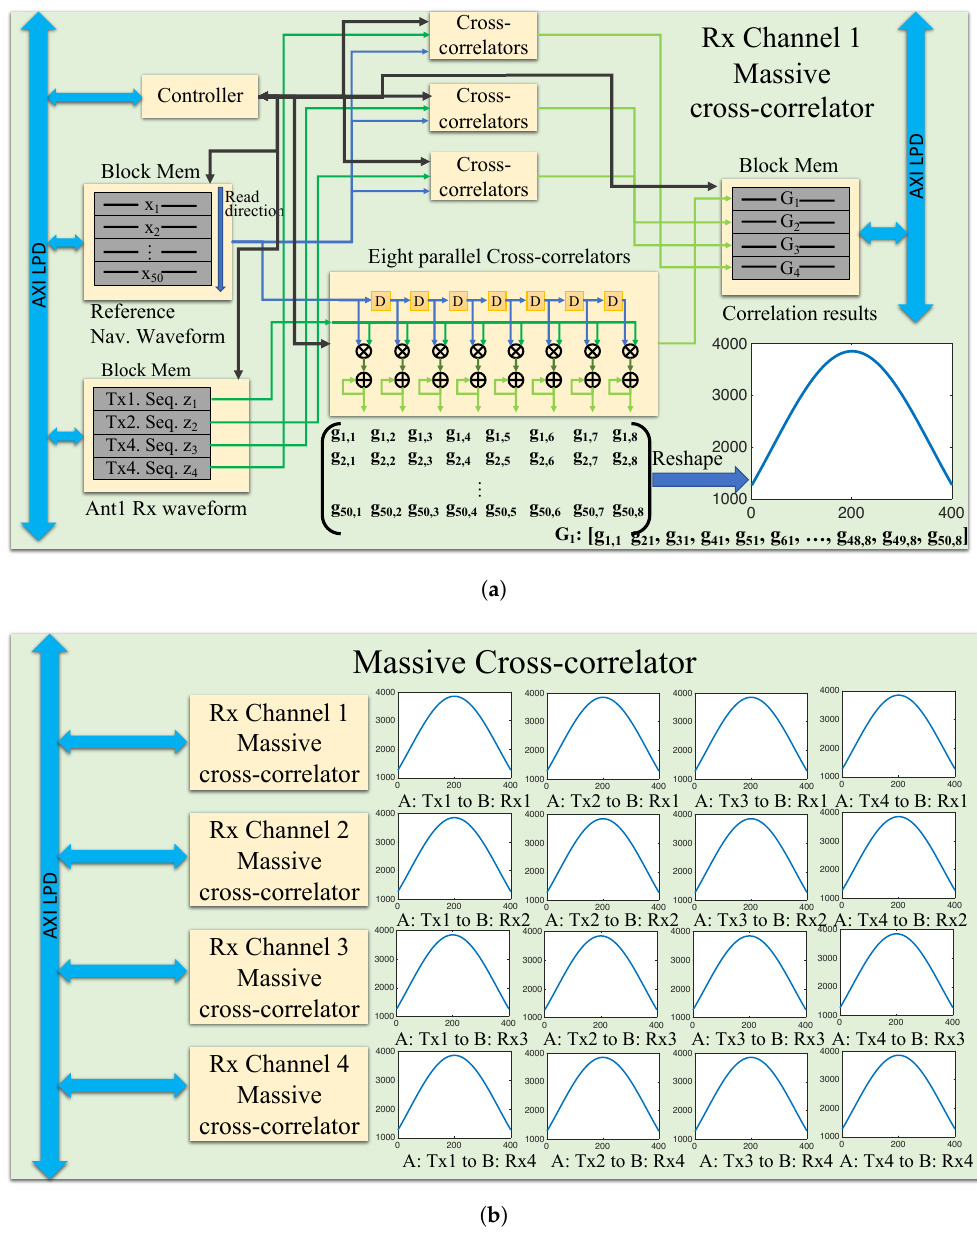
Figure 18. Implementation diagram of 16 simultaneous correlation banks for a 4 × 4 configuration. ( a ) Each receiving chain has four dedicated correlators. ( b ) There are four receiver correlation channels for a total of 16 correlations – corresponding to the 16 links formed by our 4-antenna